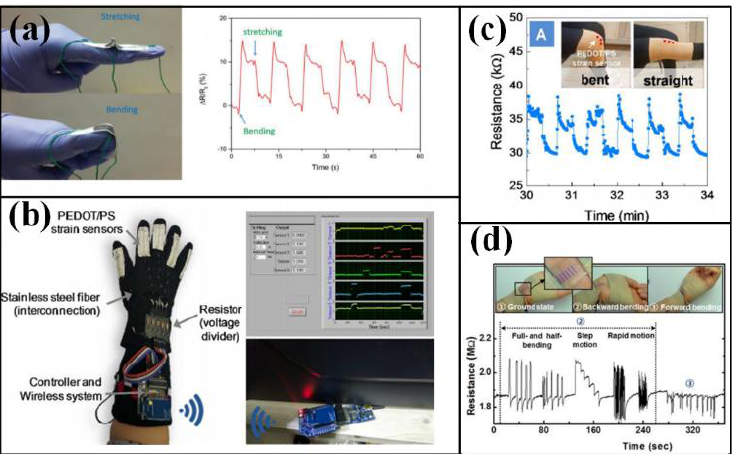
Figure 2. Movement detection of fingers, wrist and knee: ( a )detection of finger movement by single strip; ( b ) detection of finger movement by glove-like device; ( c ) detection of knee and wrist movement. Reproduced from [38] with permission of The Royal Society of Chemistry. Reprinted with permission from [36]. Copyright 2107 American Chemical Society. Reprinted with permission from [49], Copyright (2015) American Chemical Society.